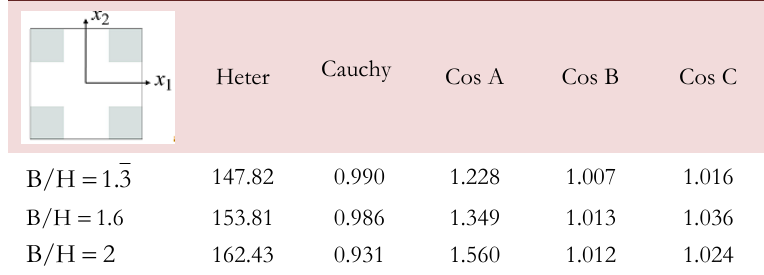
Table 3: Structural stiffness for different ratios of B/H in the case of UC1: Heter = micromechanical model; Cauchy= homogenized first order model; Cos A = homogenized Cosserat with Procedure A ; Cos B = homogenized Cosserat with Procedure B ; Cos C = homogenized Cosserat with Procedure C .